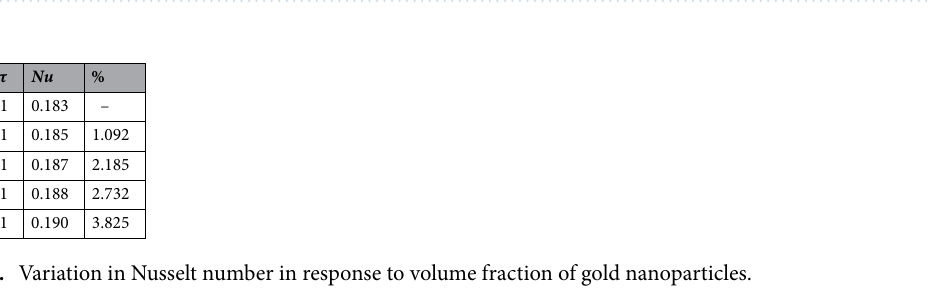
Table 1. Thermo-physical properties of base fluid(blood) and gold nanoparticles 8,9,49 .